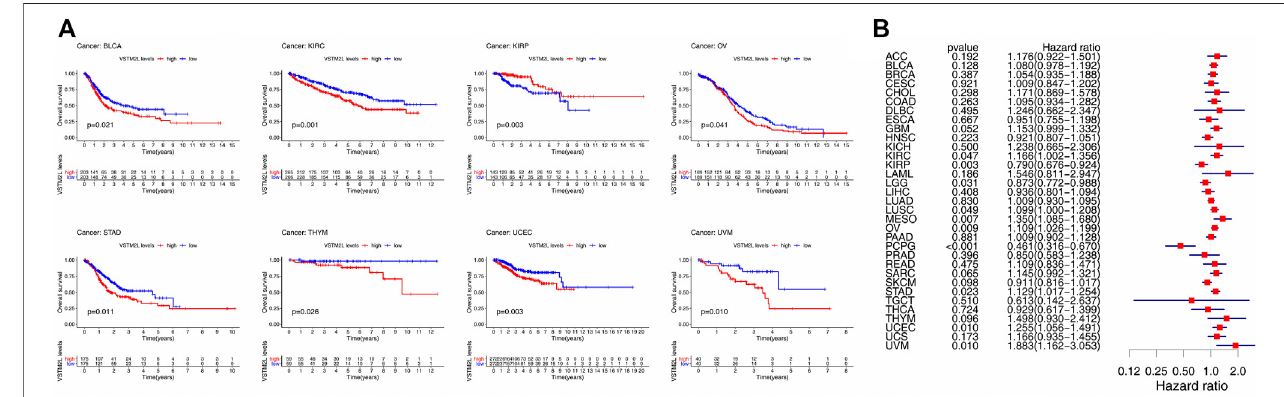
FIGURE 2 | Kaplan – Meier survival and Cox regression analyses of the prognostic value of VSTM2L expression level for OS in different cancer types. (A) OS according to high and low VSTM2L expression in BLCA, KIRC, KIRP, OV, STAD, THYM, UCEC, and UVM from TCGA database. (B) Correlation between VSTM2L mRNA expression level and OS in various cancer types. * p <